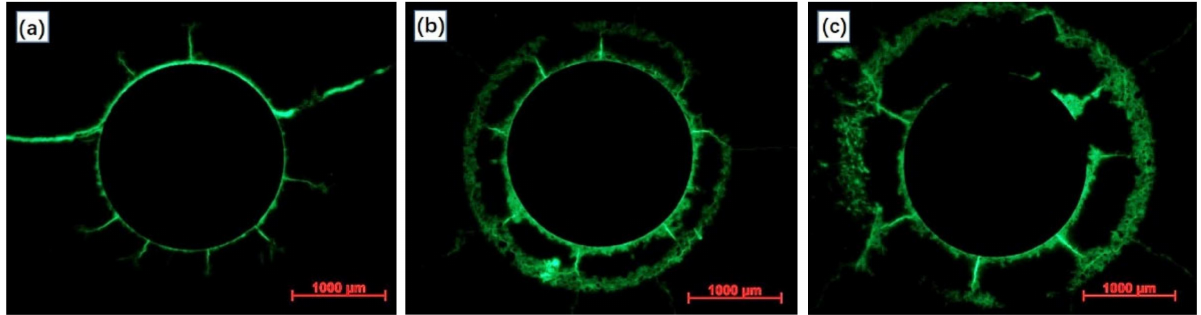
Figure 8. The fluorescence micrograph of anode samples prepared with neat cement paste in varied water to cement ratio after the constant potential polarization test: ( a ) W/C = 0.3, ( b ) W/C = 0.4, and ( c ) W/C = 0.5.